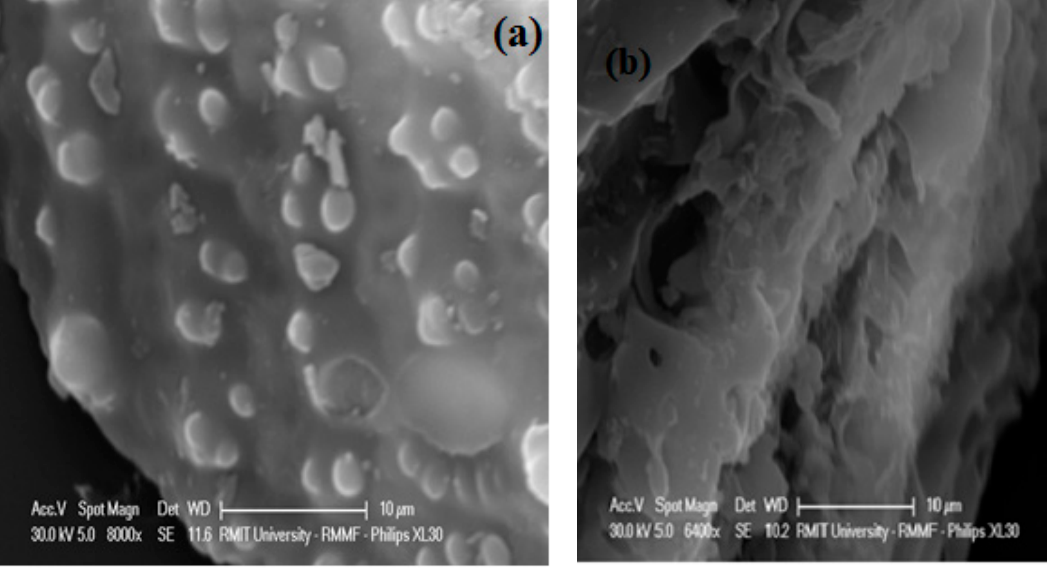
Figure 7. The SEM of ( a ) the rice straw and ( b ) the optimized hydrochar.